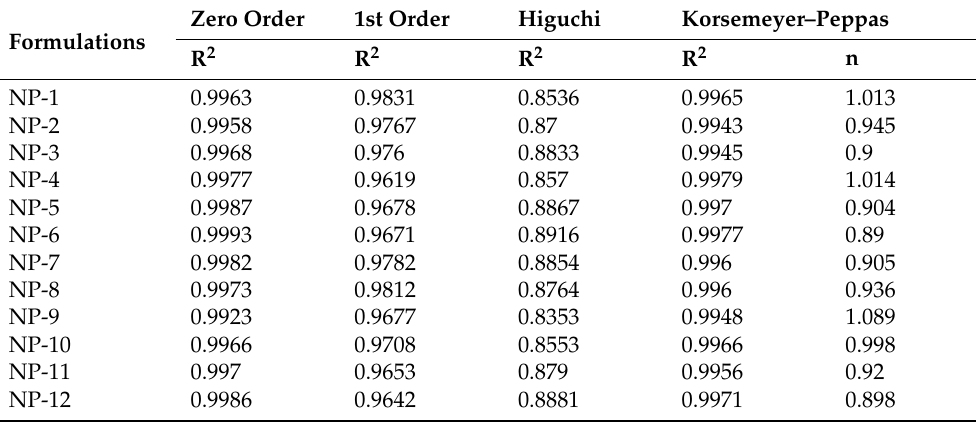
Table 2. Cytarabine release kinetics.